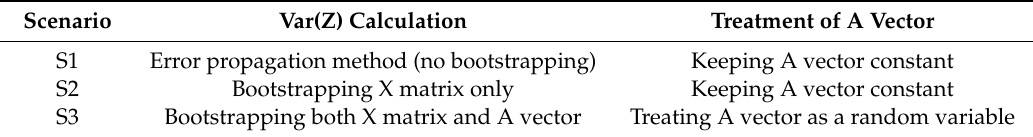
Table 1. Summary of the three di ff erent